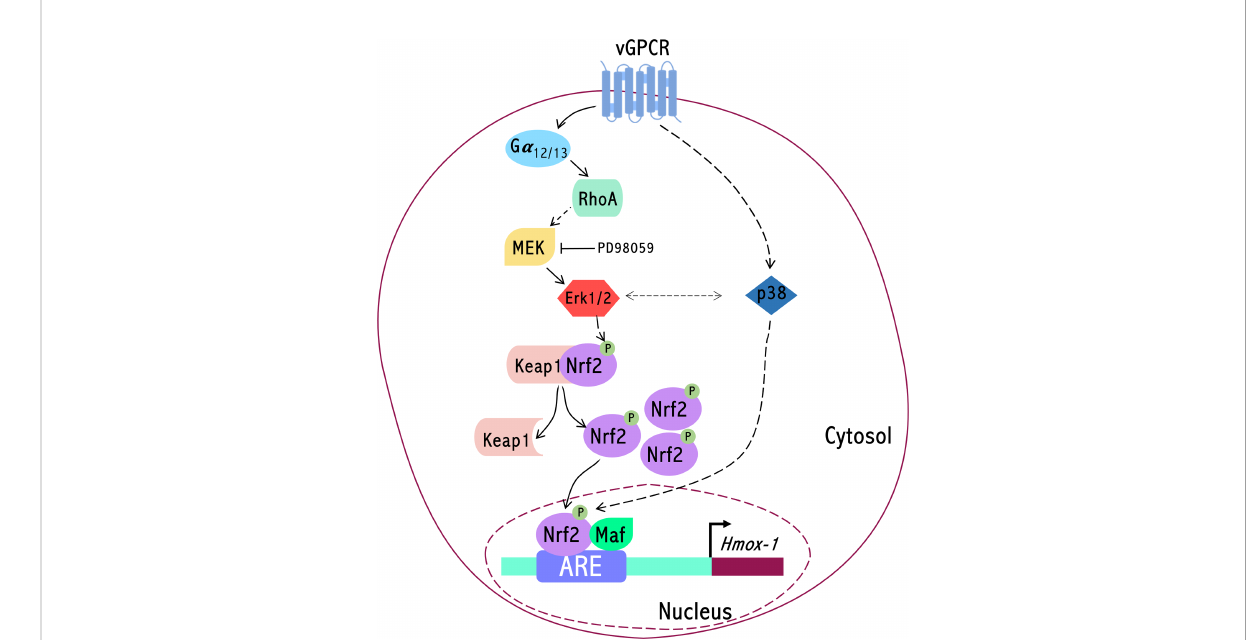
FIGURE 9 Signaling axis connecting the KSHV encoded oncogene vGPCR to the HO-1 promoter (Hmox-1) involves G a 12/13 and RhoA dependent Erk1/2 MAPK mediated activation of the transcription factor